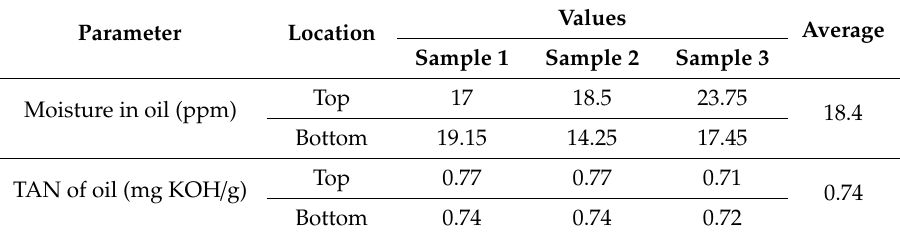
Table 2. Oil properties measured before post-mortem